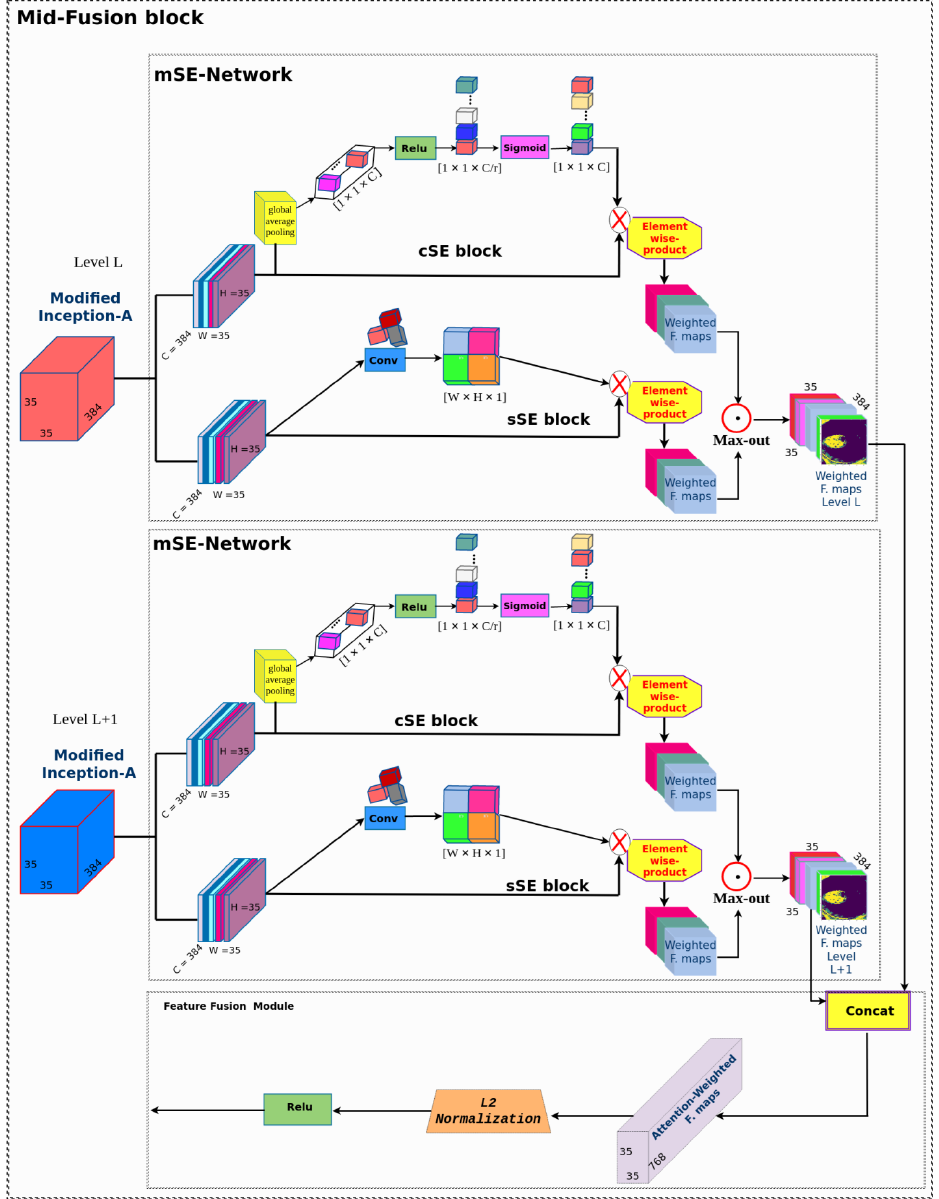
Figure 4. The mid-fusion framework. Input feature maps were created at two successive incep- tion modules of the inception v4 network to encode contextual information. All scale sizes are 35 × 35 × 384. Extracted features were passed to the mSE-Network to generate the score maps, reflecting the importance of features at different positions and scales. Weighted features were then concatenated and normalized to complete the network